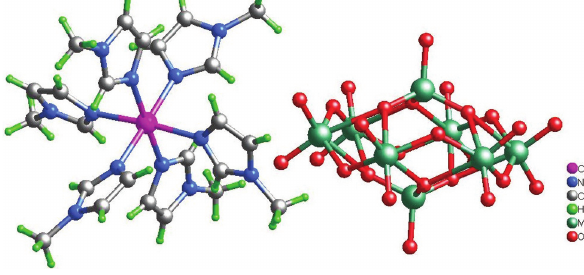
Table 1: Data collection and handling.